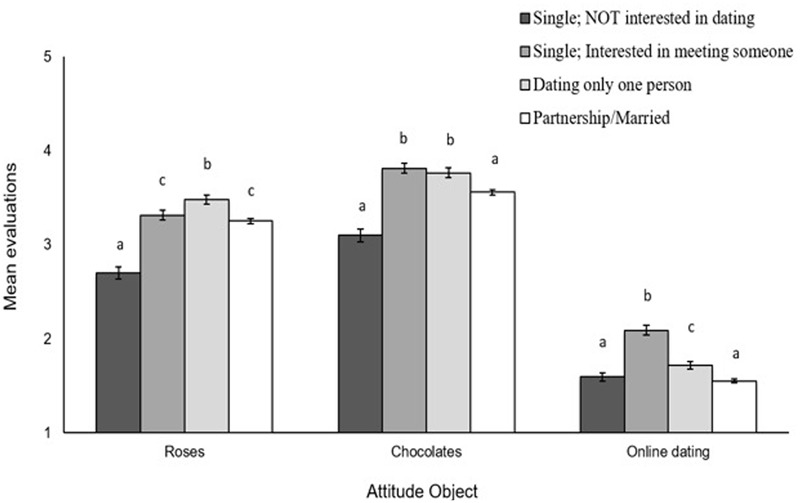
Mean evaluations of roses, chocolates, and the online dating product as a function of relationship status (single and not interested in dating; single and interested in meeting someone; dating only one person; partnership/married). Evaluations were made on a scale from 1 (not at all) to 5 (extremely). Higher numbers reflect greater positivity. Error bars represent 95% CI. Within each object, means with different letters differ significantly at p < 0.001 using Tukey’s HSD test.